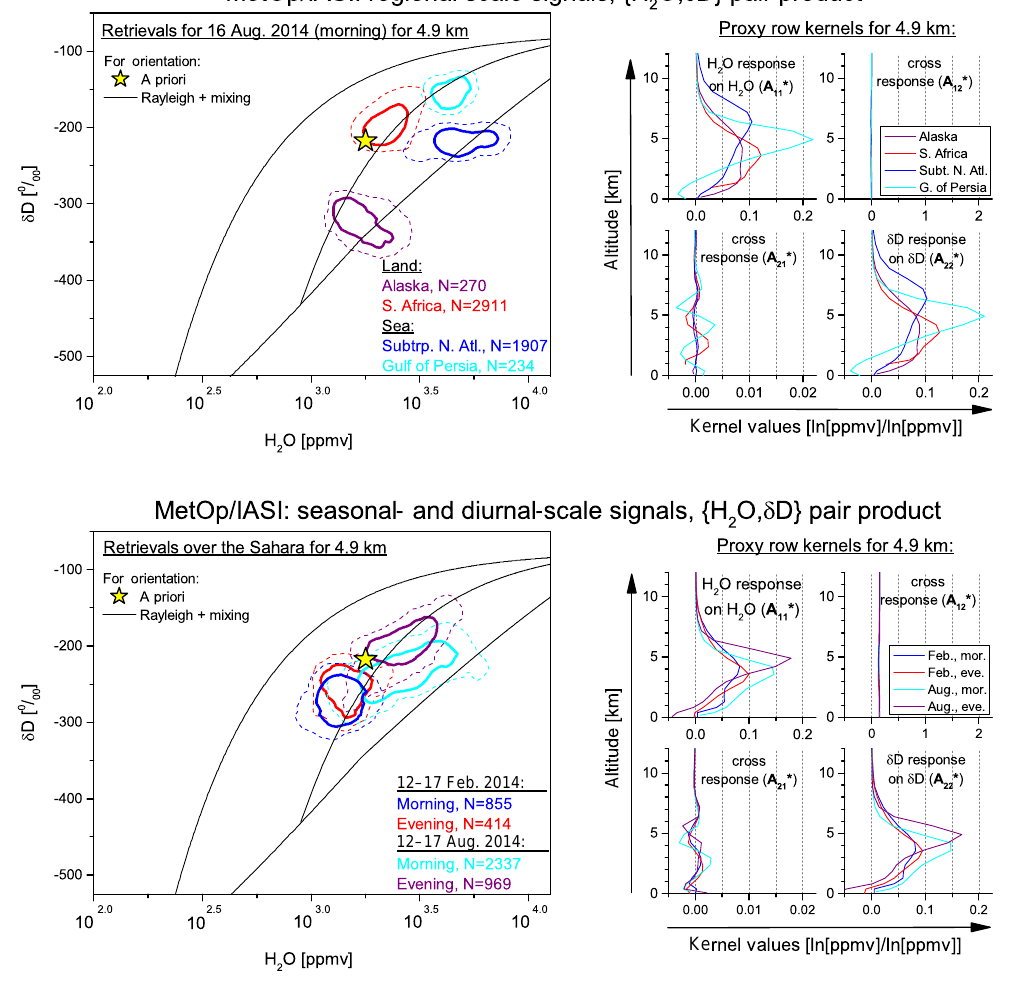
Figure 10. Example of regional-scale signals (top panels), and seasonal- and diurnal-scale signals (bottom panels) in the {H 2 O, δ D} pair distribution as obtained from IASI-A and IASI-B spectra. The left panels show the distribution density plots for retrieval results of 4.9km, whereby the thin dashed and thick solid lines mark the areas that include 95 and 66% of all data, respectively. The different colours correspond to the regions, seasons and daytime as marked in Fig. 9 and as explained in the legends. The yellow star and black lines are the a priori and the simulated lines as in Figs. 5, 6 and 8. The right panels show the corresponding typical row kernels for 4.9km for the H 2 O and δ D proxies as well as for their cross-responses (for more general details about the IASI kernels, see Fig. 2 and corresponding